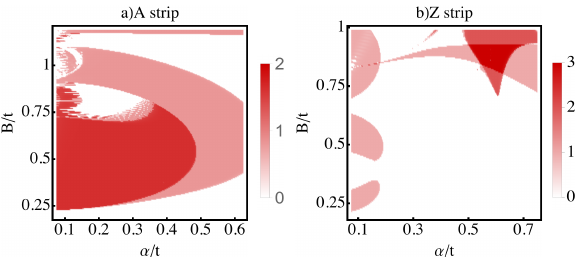
Figure 5: The total MP as a function of the spin-orbit value and magnetic field for A strips (left panel, µ = 0.1 t ), and for Z strips (right panel, µ = 0.2 t ). We take W = 5 a , L = 260 a , and ∆ = 0.2 t